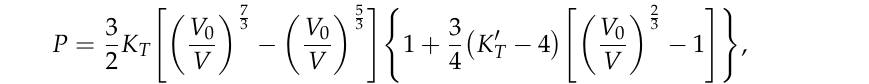
Figure 5. Evolution of the average bond length ( d mean ) and ECoN parameters of the polyhedra of the Fo-IV phase as pressure increases from 0 to 100 GPa (0 K). For the information about the Mg(I) and Mg(II), see Supplementary Tables S6-S8.